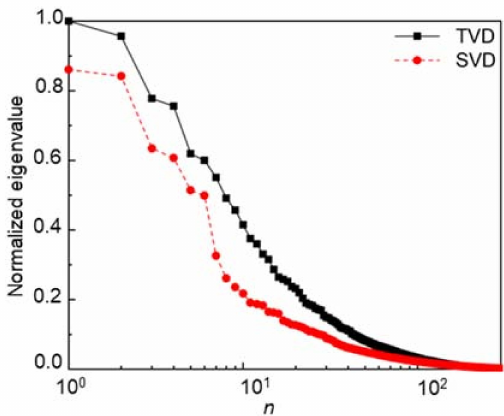
Figure 19. Normalized eigenvalues of the first 300 POD modes.